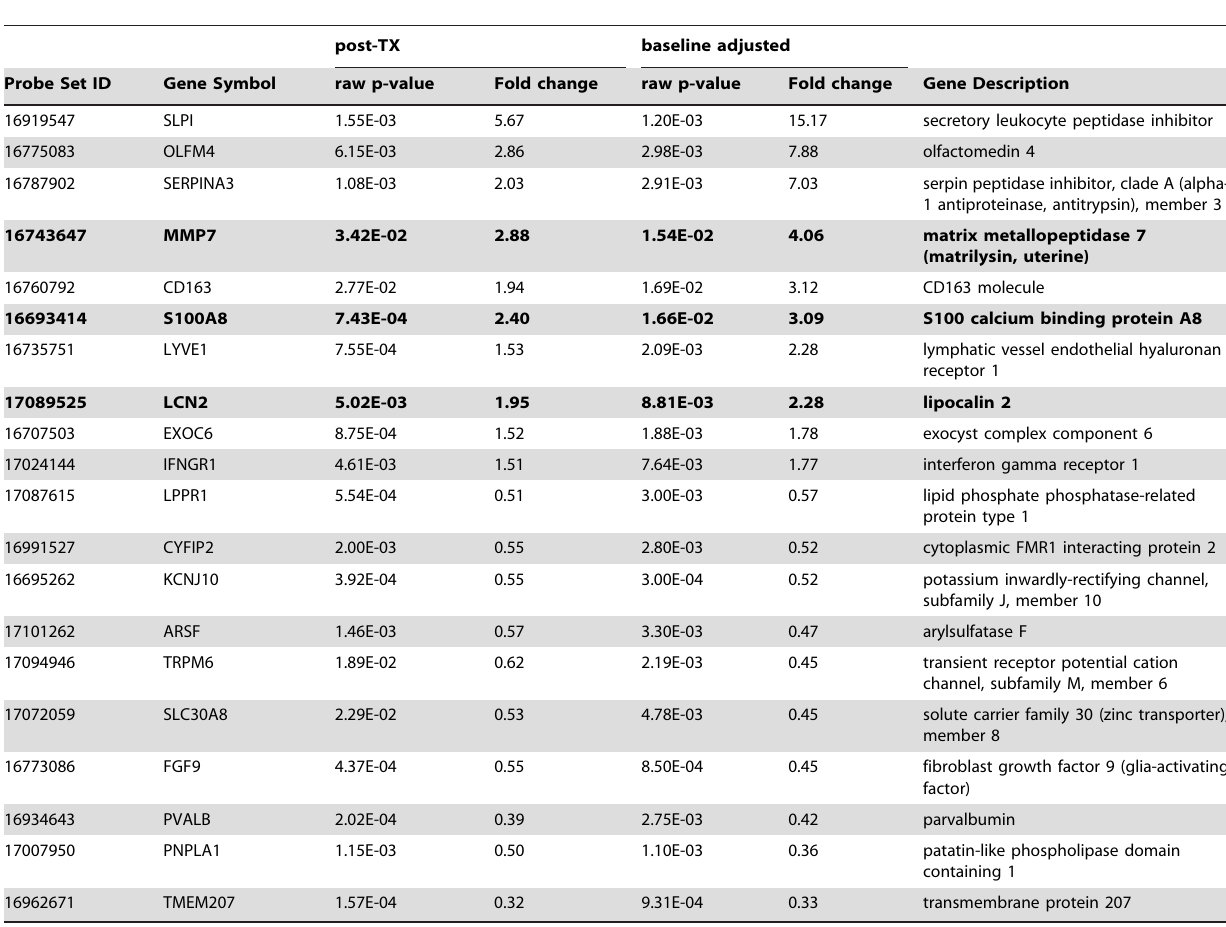
Table 2. AKI mRNA signature as verified in the independent evaluation dataset.